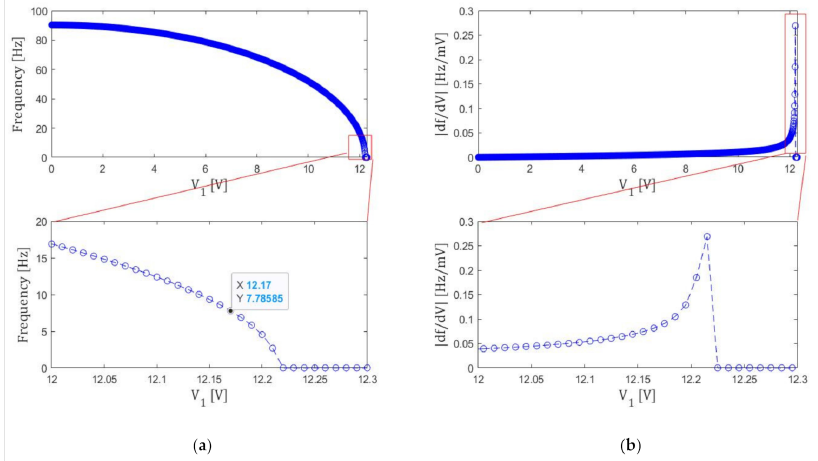
Figure 6. (a) Voltage V 1 dependence of the resonance frequency f . (b) Its derivative | ∂ f / ∂ V 1 | .